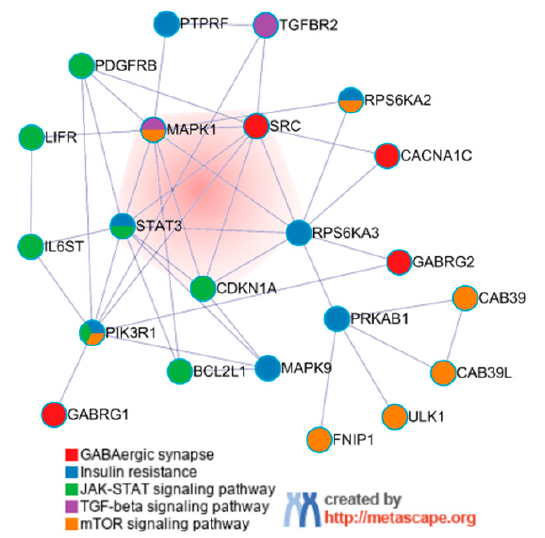
Figure 3. PPI network of five downregulated pathways. The red part at the center represents the MCODE components identified in the PPI network.